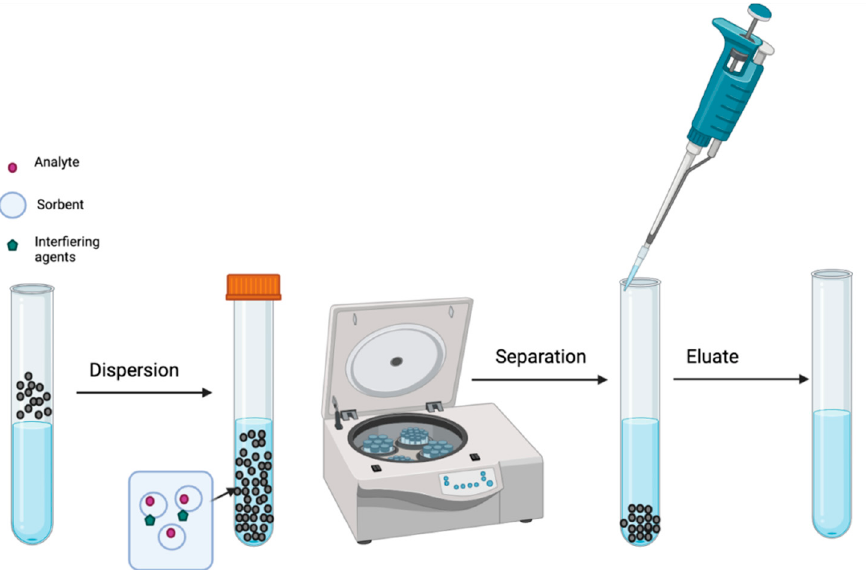
Figure 4. DSPE procedure is based on the dispersion of a solid adsorbent in a sample composed by a solvent and the target analytes. The sorbent can interact with the target analytes and could be easily separated using only centrifugation or filtration.